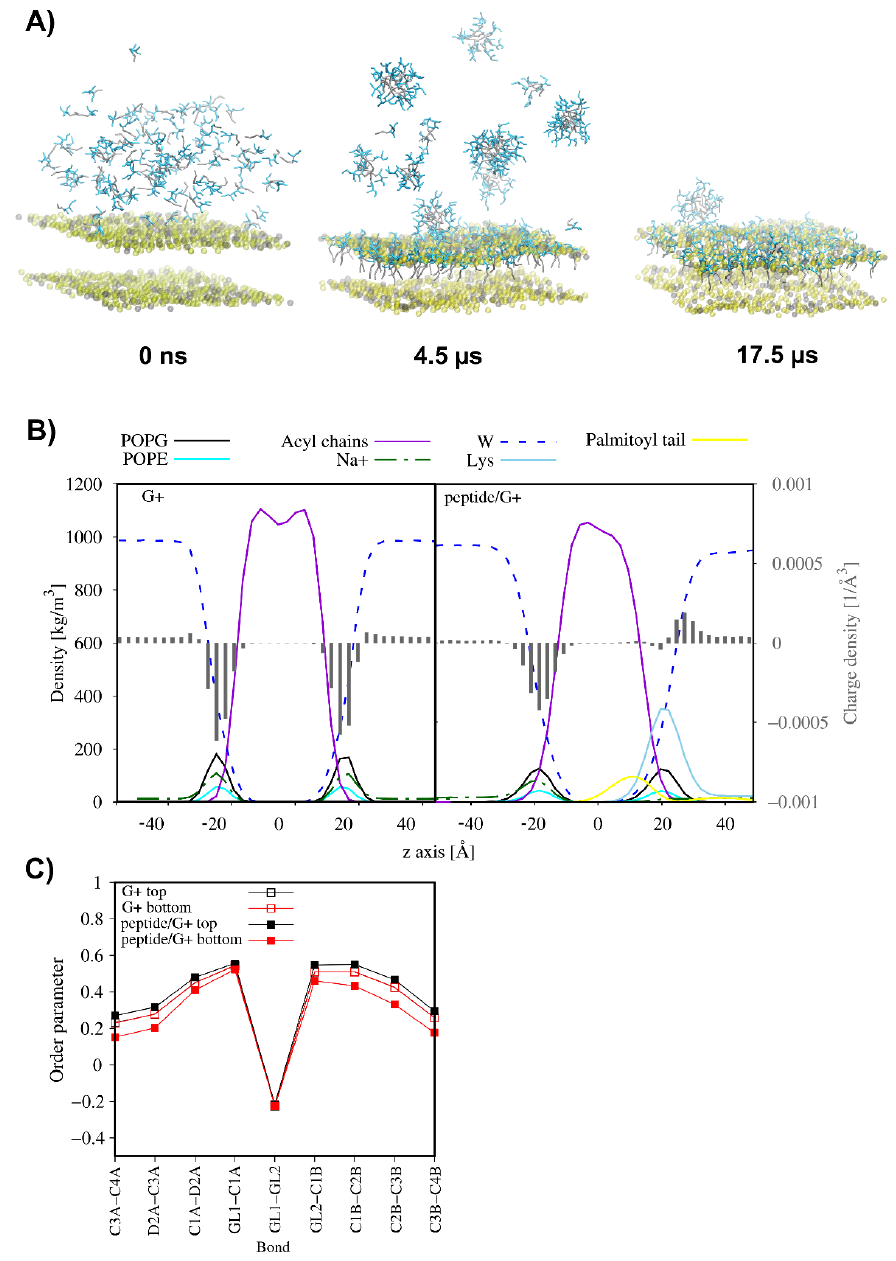
Figure 7. Representative snapshots from the 3:1 POPG/POPE binding CG MD simulations for C 16 - KKKK-NH 2 . For clarity, only phosphate beads of the membrane have been displayed. The POPE and POPG phosphate groups are indicated in gray and yellow, respectively. Palmitoyl tails are in gray, while lysine residues are in cyan ( A ). Partial density and charge density profiles averaged over the last 100 ns of the CG MD simulations ( B ) and comparison of the lipid acyl chain order parameters of the lipids in the outer and inner leaflet of the membrane in the absence of the lipopeptide and in the presence of the lipopeptide ( C ).